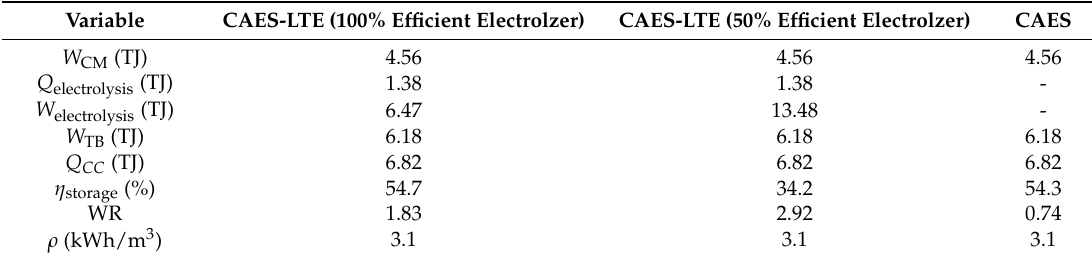
Table 7. Simulation results for the conventional CAES and CAES-LTE